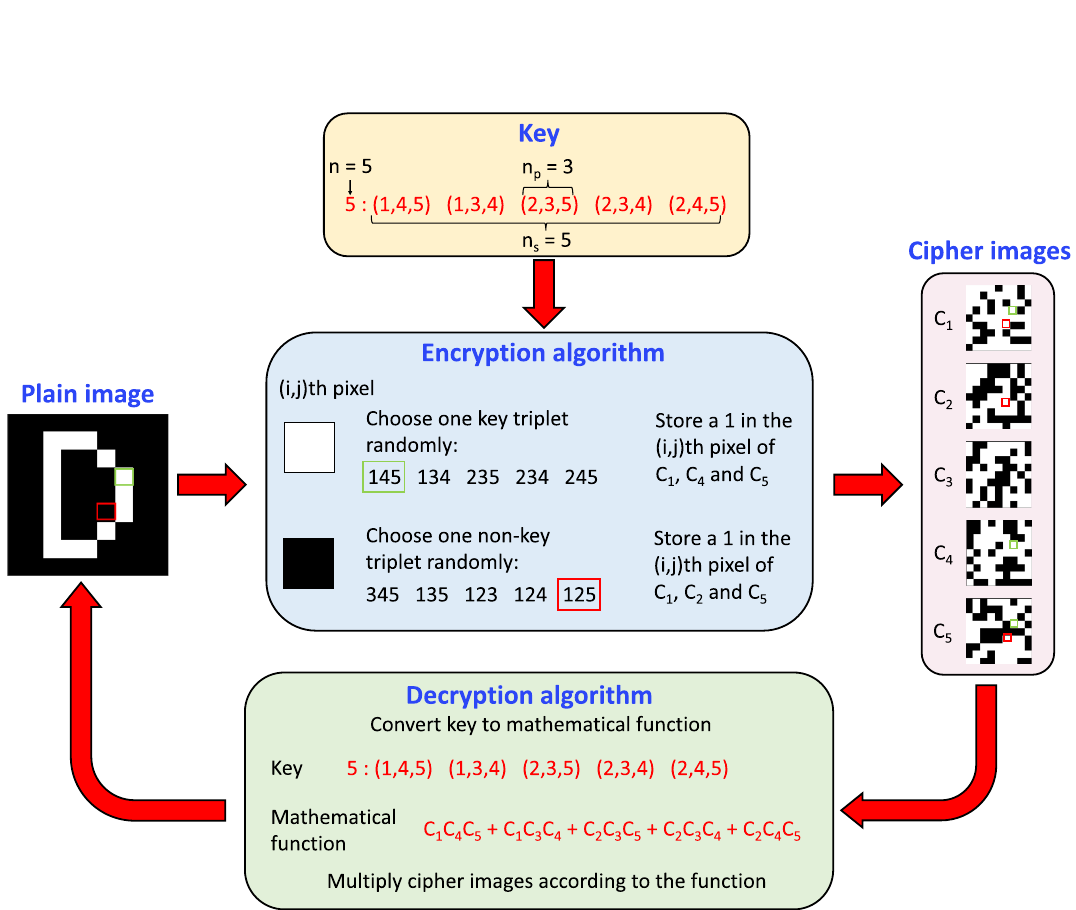
Figure 2. Encryption and decryption algorithms. A 9 × 9 pixel binary image of the letter ‘D’ is input to the encryption algorithm that uses a key to convert it into a set of 5 seemingly random cipher images. The decryption algorithm uses the same key to retrieve the letter ‘D’